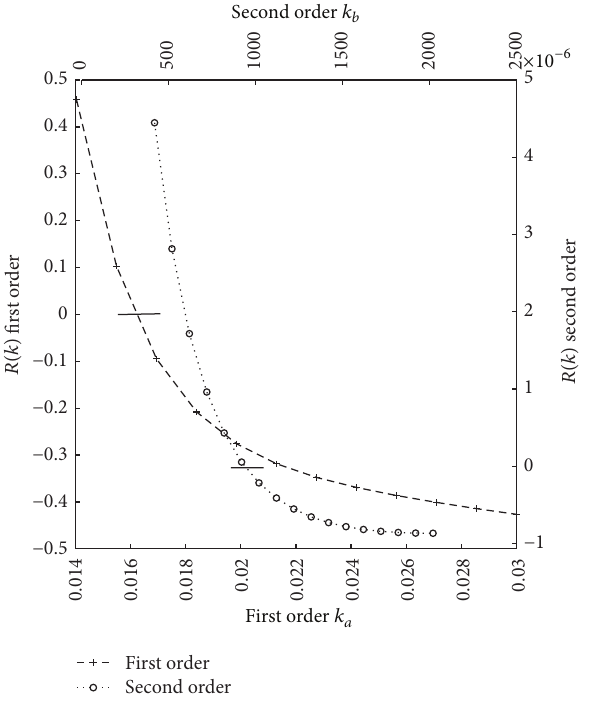
Figure 3: 𝑅(𝑘) functions (10) for reactions (i) and (ii) of order one and two in reaction rate. The horizontal bars correspond to the zero values of the 𝑅(𝑘) functions.